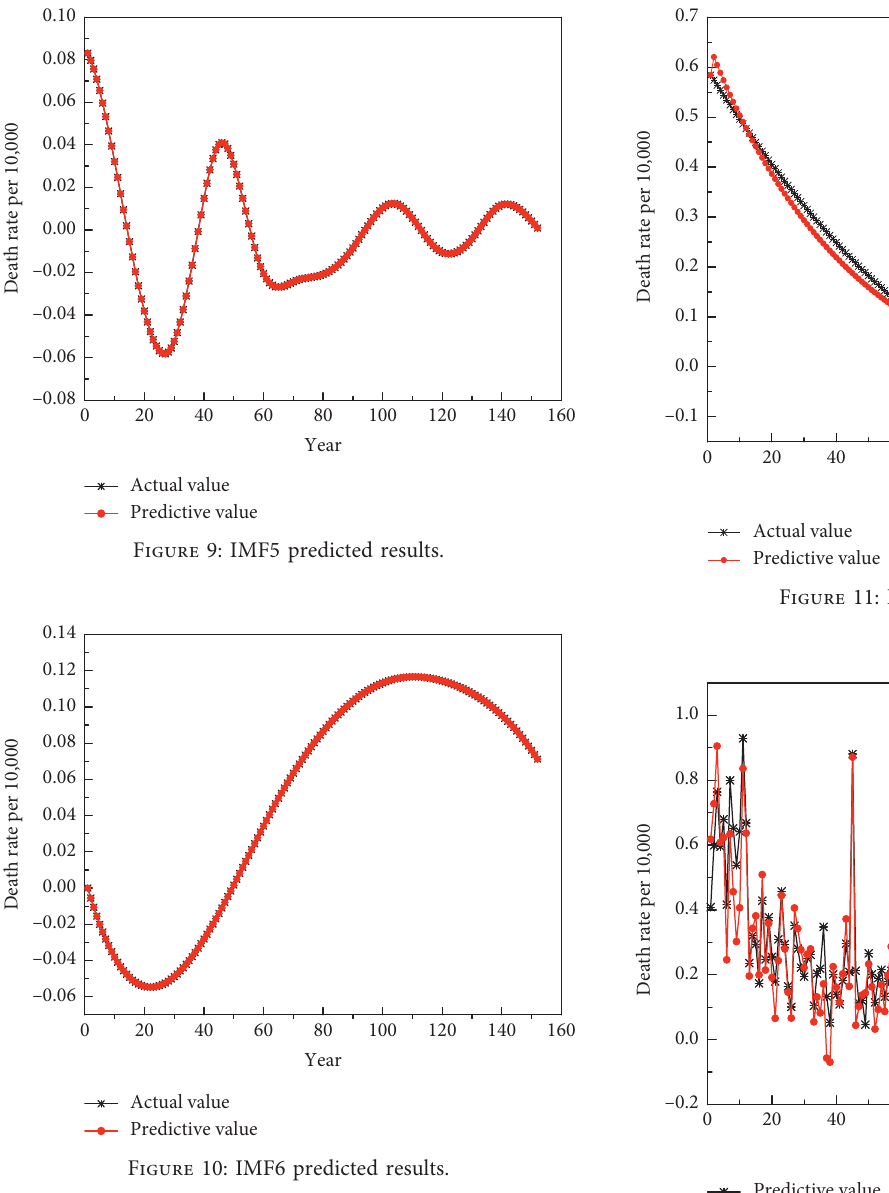
Figure 10: IMF6 predicted results.